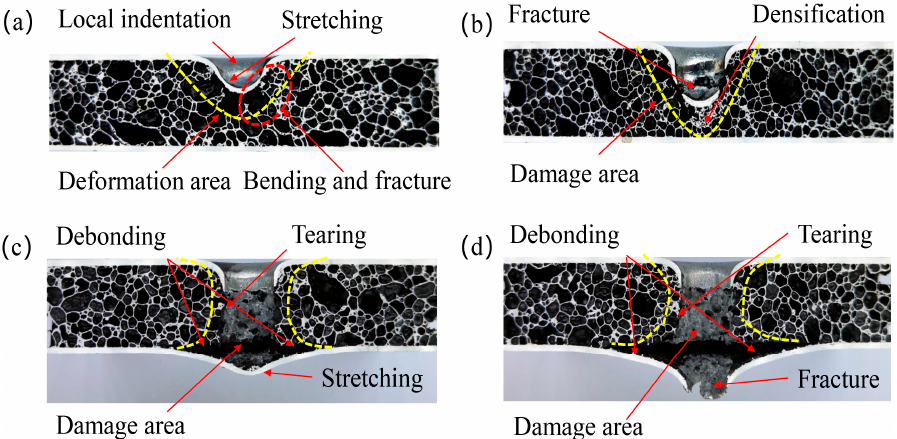
Figure 6. The failure mode of the AFS core layer under different impact energy: ( a ) 32 J; ( b ) 60 J; ( c ) 90 J; ( d ) 120 J.